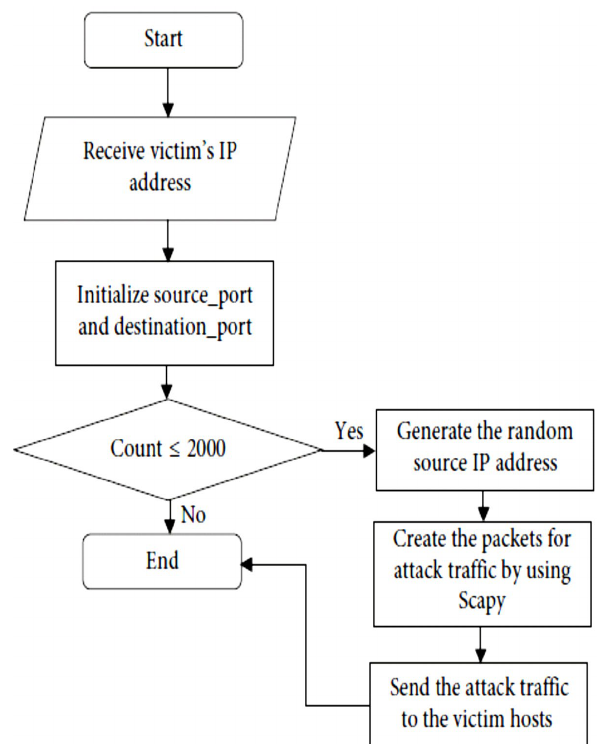
Figure 2. Step by step UDP Flooding Spasm Process.